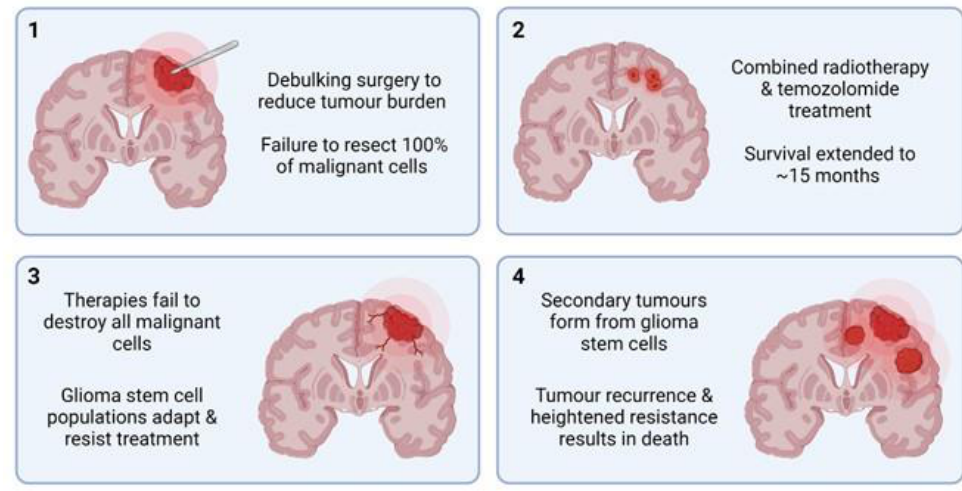
Figure 3. Overview of the current ‘gold standard’ GBM treatment strategy. Panel 1: Debulking surgery is performed to remove as much tumour mass as possible. Due to extensive infiltration, some metastatic cells inevitably remain. Panel 2: Combined radiotherapy and temozolomide (TMZ) treatment is administered over several months. Panel 3: Remaining malignant cells (primarily GSCs) overcome and adapt to TMZ treatment, continuing to proliferate. Panel 4: Inevitably, tumour recurrence and metastasis occur, resulting in eventual death.~: Median survival.